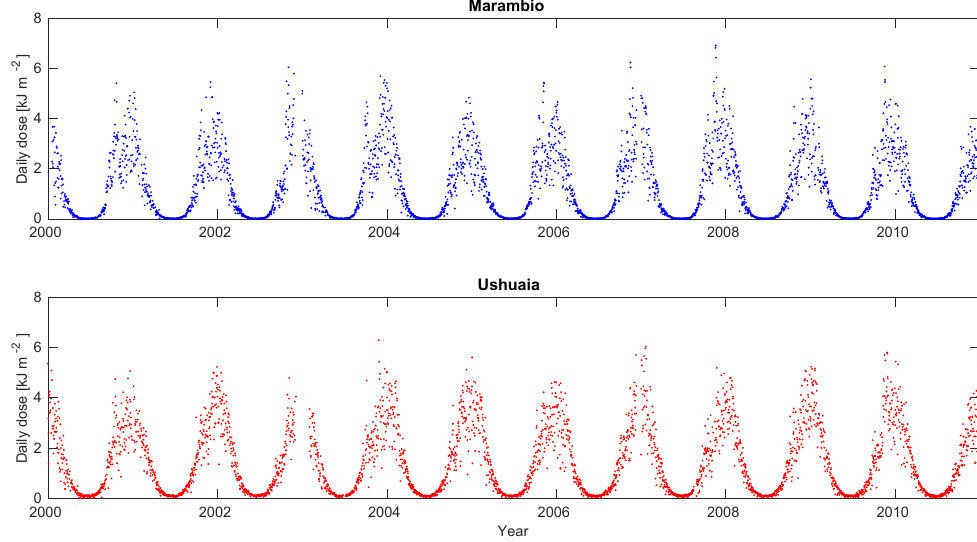
Figure 5. Erythemally weighted daily doses measured at Marambio and Ushuaia during